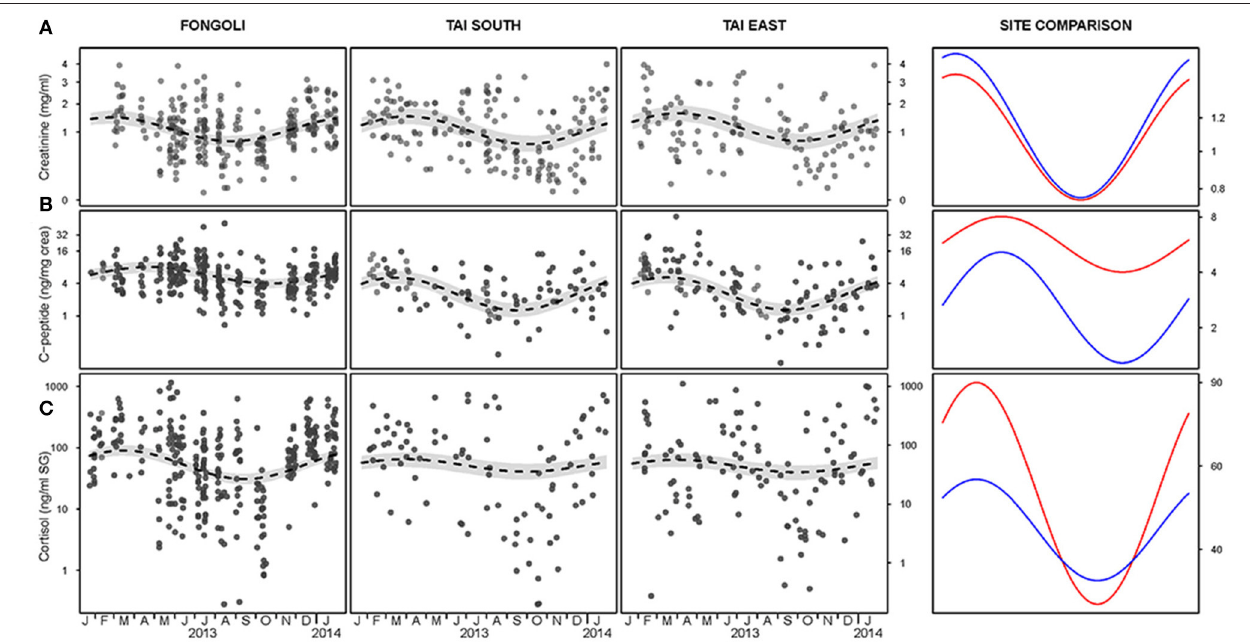
FIGURE 3 | Adjusted and unadjusted seasonal variation of creatinine (A) , c-peptide (B) , and cortisol (C) levels at three chimpanzee communities. Fongoli is displayed in red and Taï in blue in the adjusted seasonal comparison (right column). All y-axes are displayed on a log scale except for creatinine (A) which is displayed on the square-root scale; confidence intervals are displayed in